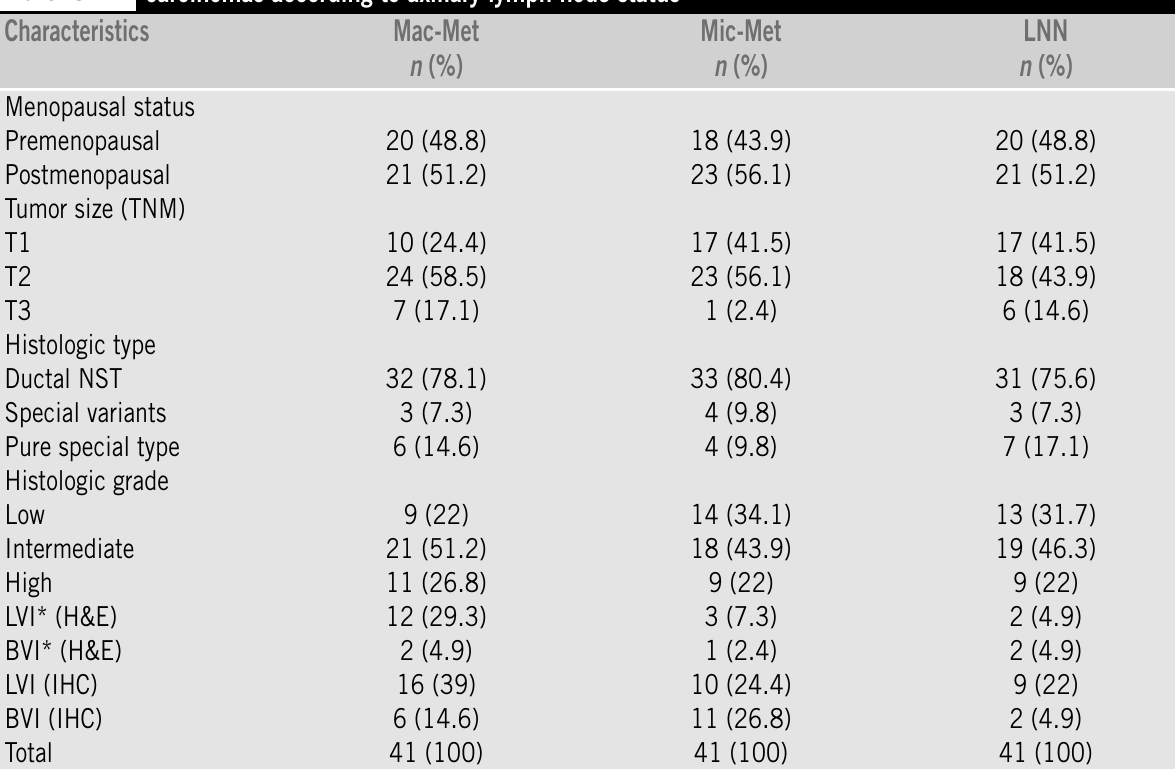
Clinicopathologic and immunohistochemical features of 123 cases of invasive mammary carcinomas according to axillary lymph node status